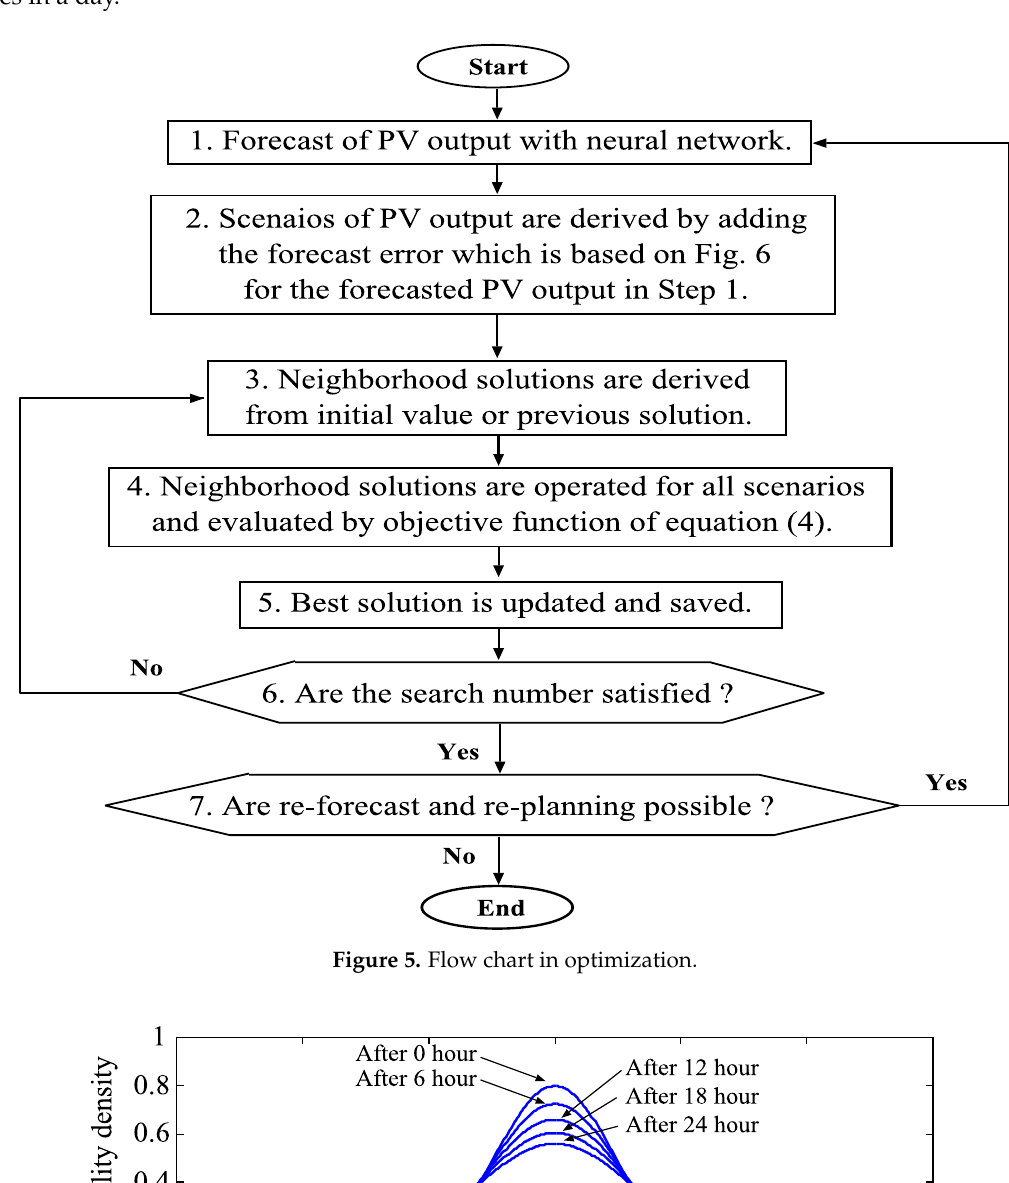
Figure 6. Forecast error probability distribution for photovoltaic (PV) output